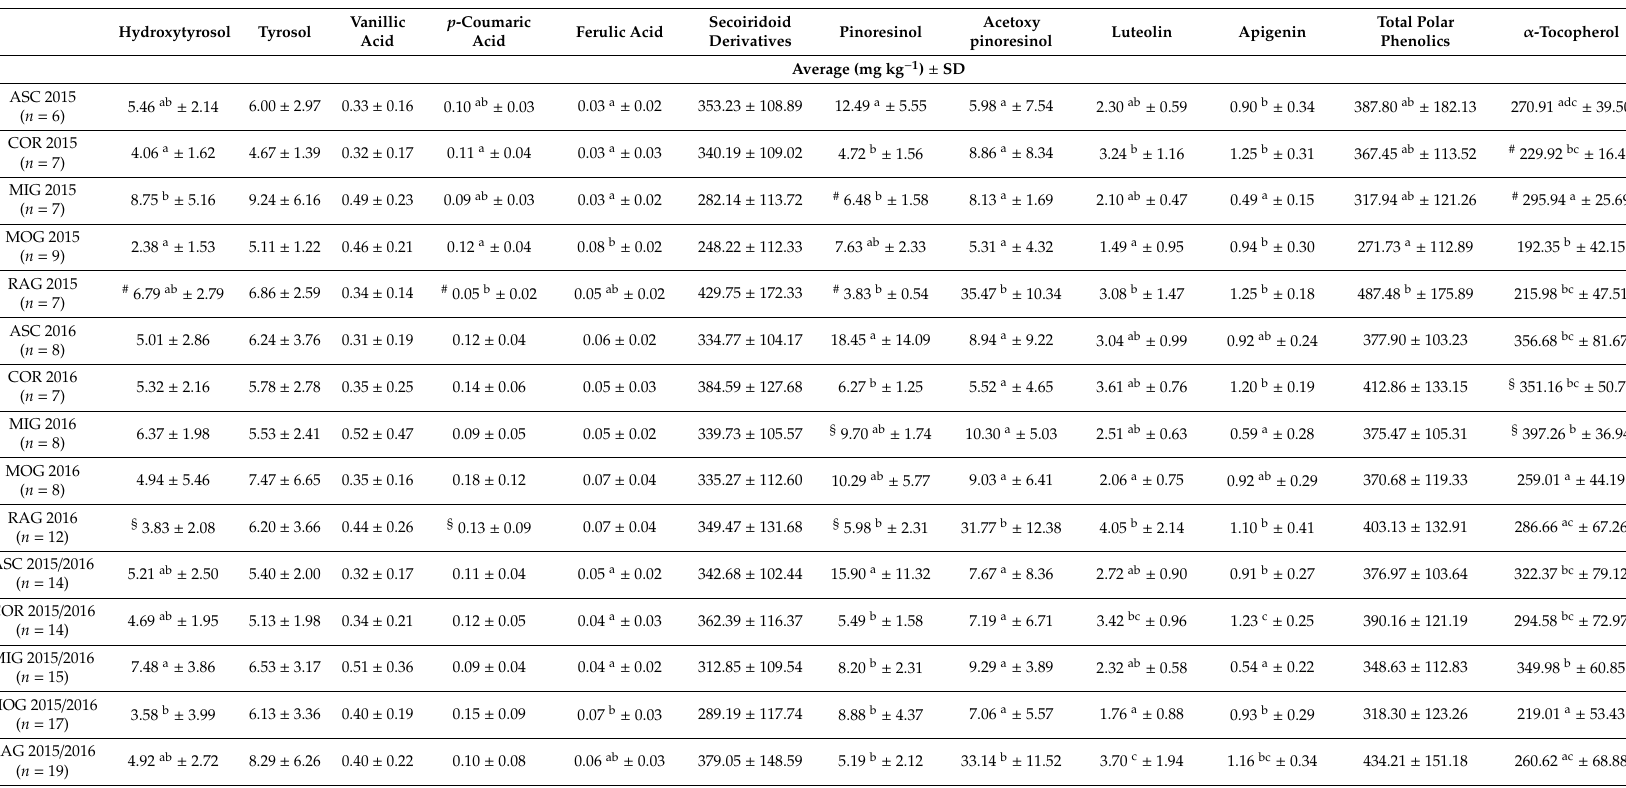
Table 1. Average content of polar phenolic substances and of α -tocopherol ± standard deviation (SD) in the investigated monovarietal oils (ASC: Ascolana tenera, COR: Coroncina, MIG: Mignola, MOG: Piantone di Mogliano, RAG: Raggia) produced in 2015 and 2016 and in the total 2015 / 2016